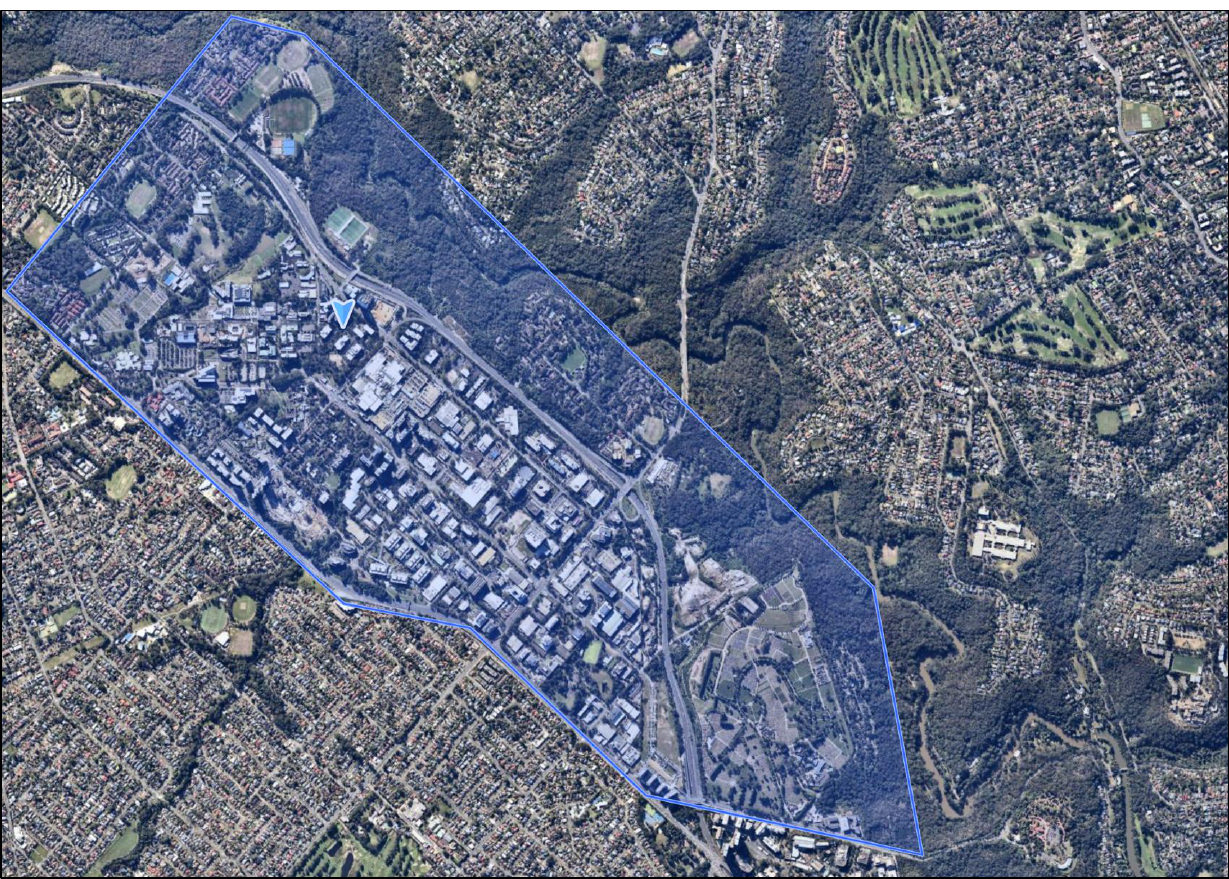
Figure 2. Location of Macquarie Park Innovation District.